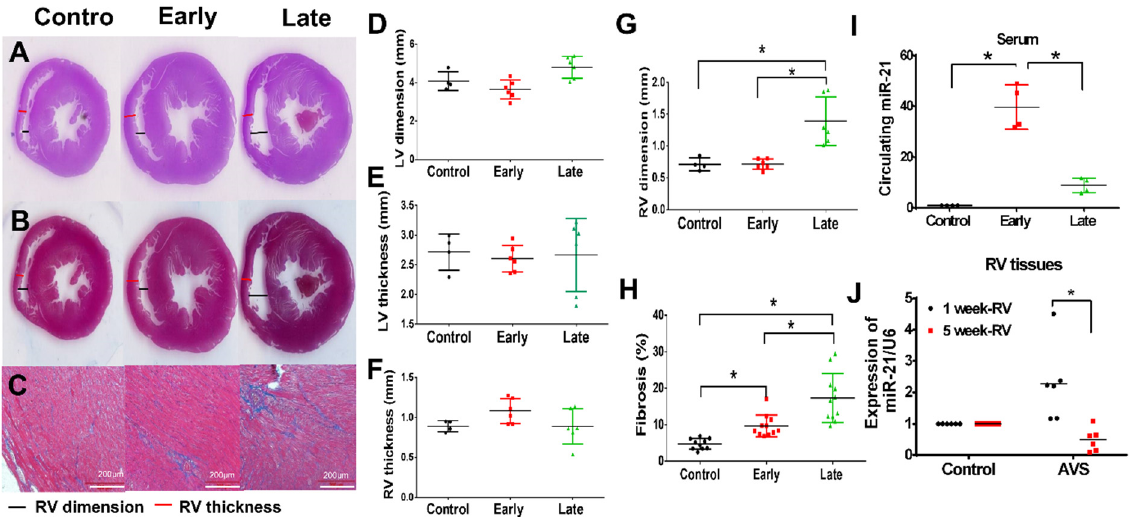
Figure 2. Right ventricular (RV) failure in rats subjected to arteriovenous shunt (AVS) is associated with a downregulation of MiR-21. The rats subjected to AVS in early (7 days) and late (28 days) phases, ( A ) the hematoxylin and eosin stain and ( B , C ) Masson trichrome staining of heart sections in indicated groups; scale bars, 200 µm. Quantification of ( D ) LV dimension, ( E ) LV thickness, ( F ) RV thickness, ( G ) RV dimension and ( H ) cardiac fibrosis in indicated groups. The expression of miR-21 in human plasma circulating ( I ) and RV tissues ( J ) in indicated groups. Data are expressed using mean ± standard deviation (S.D.). * p < 0.05 for difference between each group. (N = 4–6).